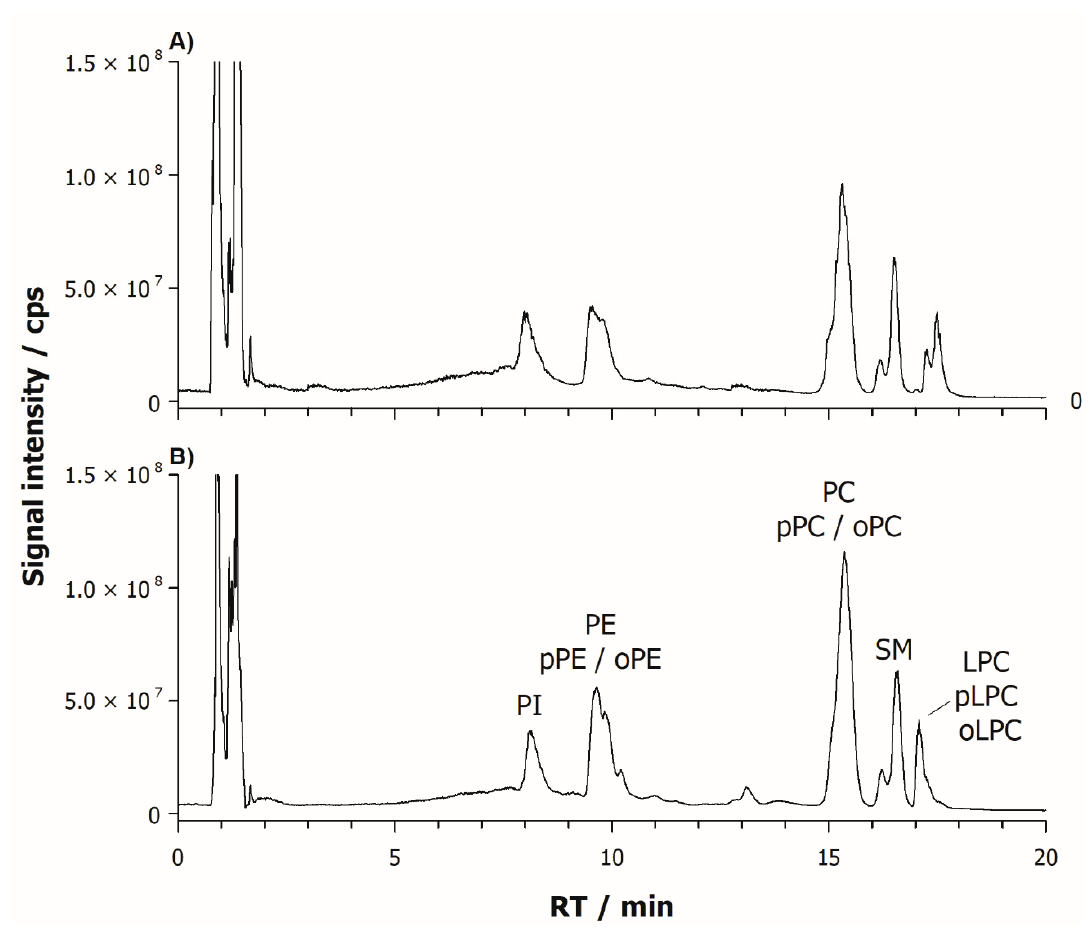
Figure 1. Total ion chromatograms (TICs) of human fibroblast lipid extract relevant to control cells ( A ) and Parkinson’s disease (PD) patient at Hoehn and Yahr (HY) stage 5 ( B ). TIC signals were acquired from three different independent replicates of each sample, aligned and averaged using MATLAB.